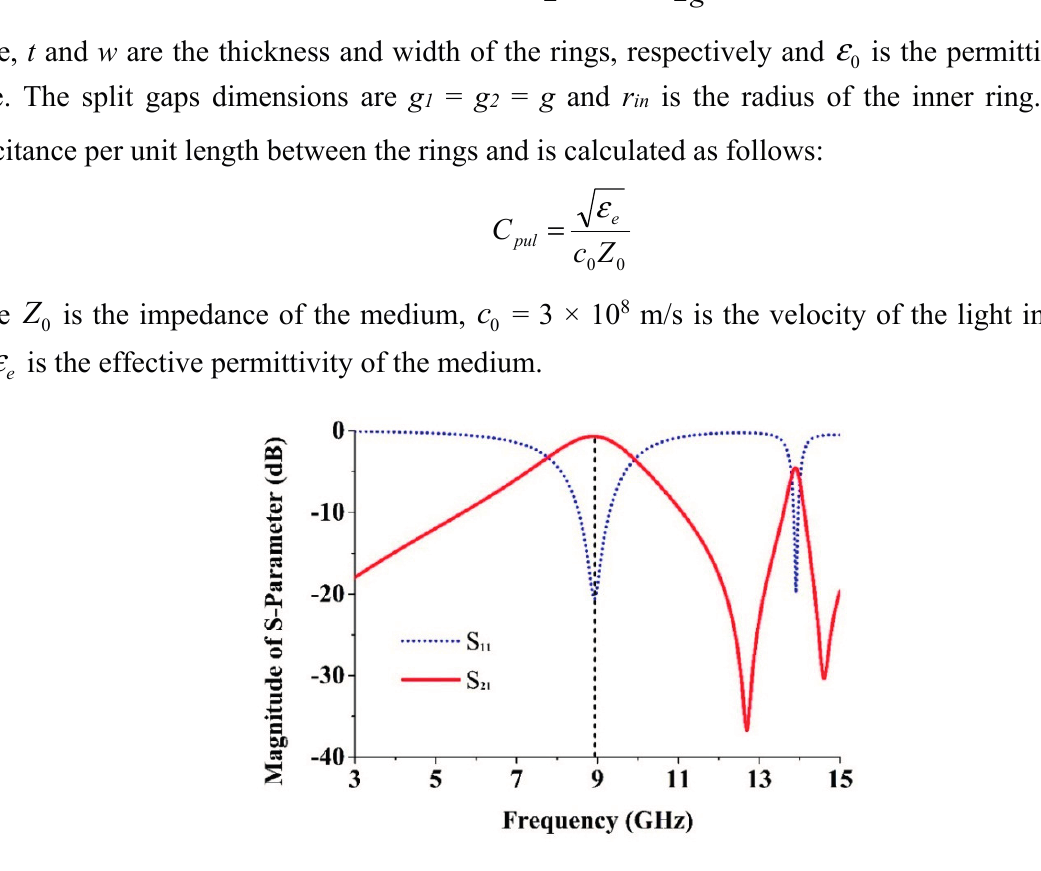
Figure 4. Simulated results of S-parameters for the unit cell plotted in Figure